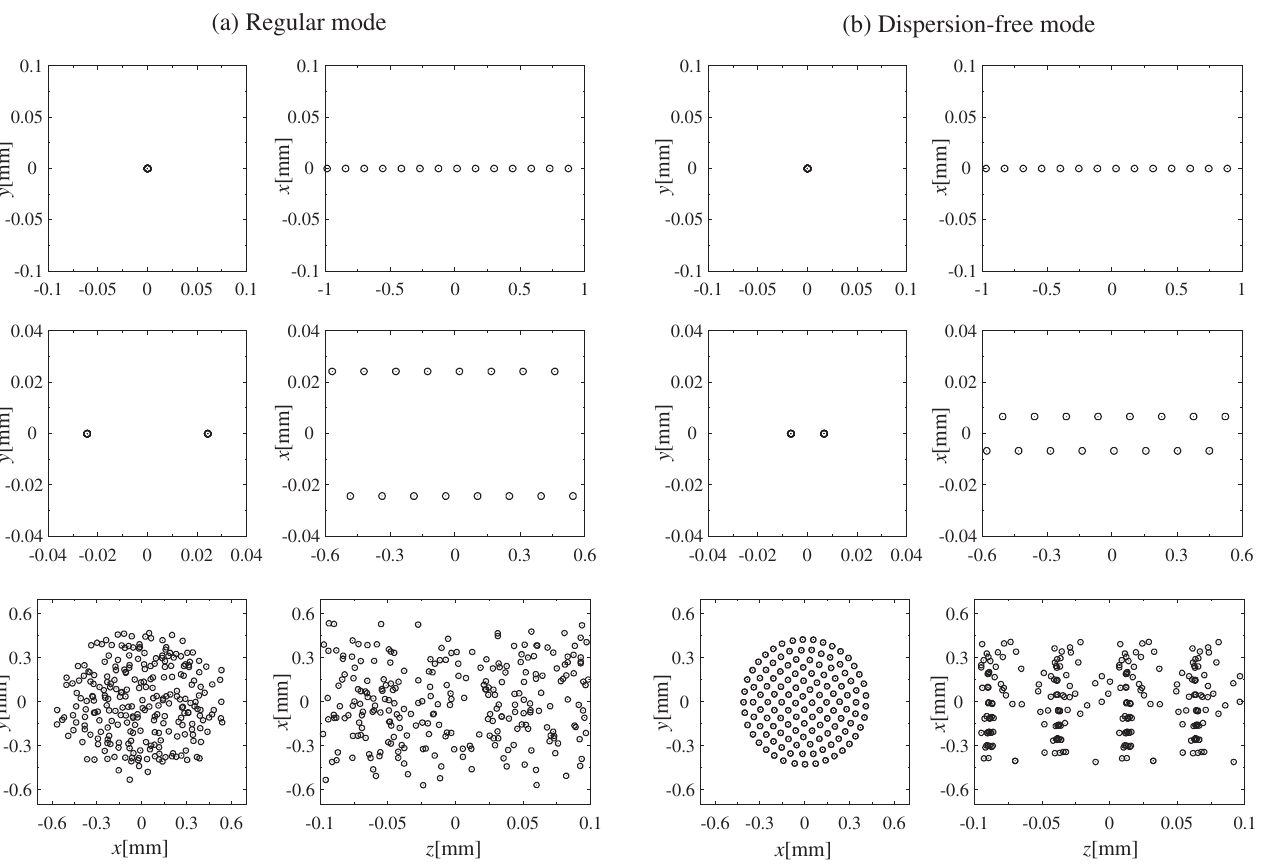
(cid:4) (cid:2) (cid:3) 2 : 23 ; 2 : 23 (cid:4) . The spatial configurations of coasting crystalline beams at ; (cid:6) x y